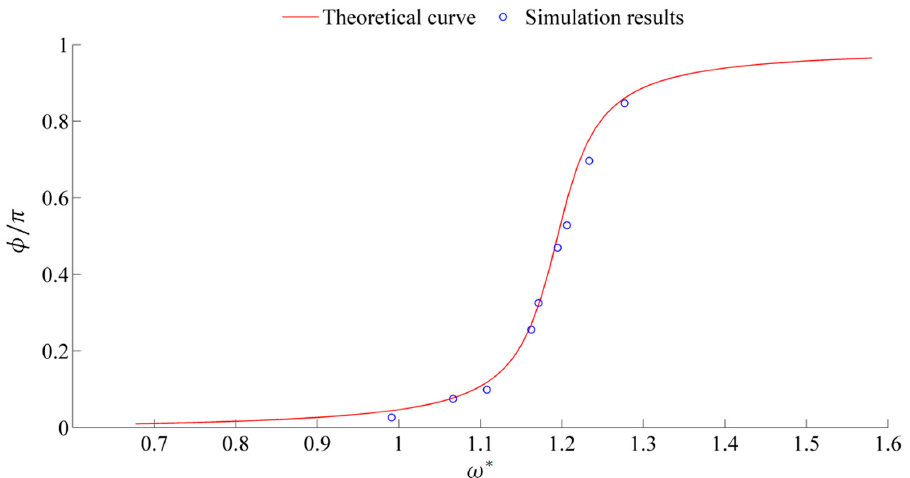
Figure 14. The comparison of the dimensionless phase leg ( Φ / π ) of the elevation inside the gap in the present simulations (evaluated based on Equation (24)) and the theoretical curve based on Equation (26a–c) ( B ∗ g = 0.1).